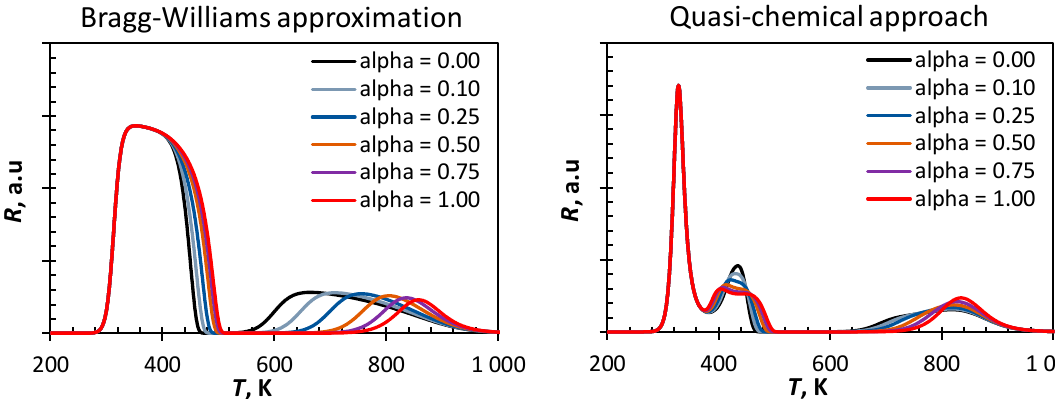
Figure 4. Sensitivity analysis of simulated CO-TPD-profile from Fe(100) ( Θ CO,initial = 1.00 ML, 10 K · s − 1 ) using a mean field approach on the variation in the factor α describing the similarity of the transition state to the initial state ( α = 0) or the final state ( α = 1) in CO-dissociation (see Equation (9)).